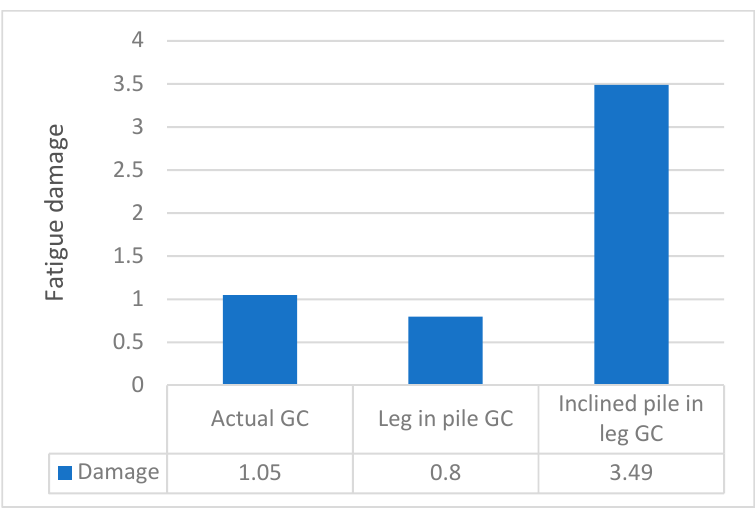
Figure 21. Effect of grouted connection on the dynamic response.